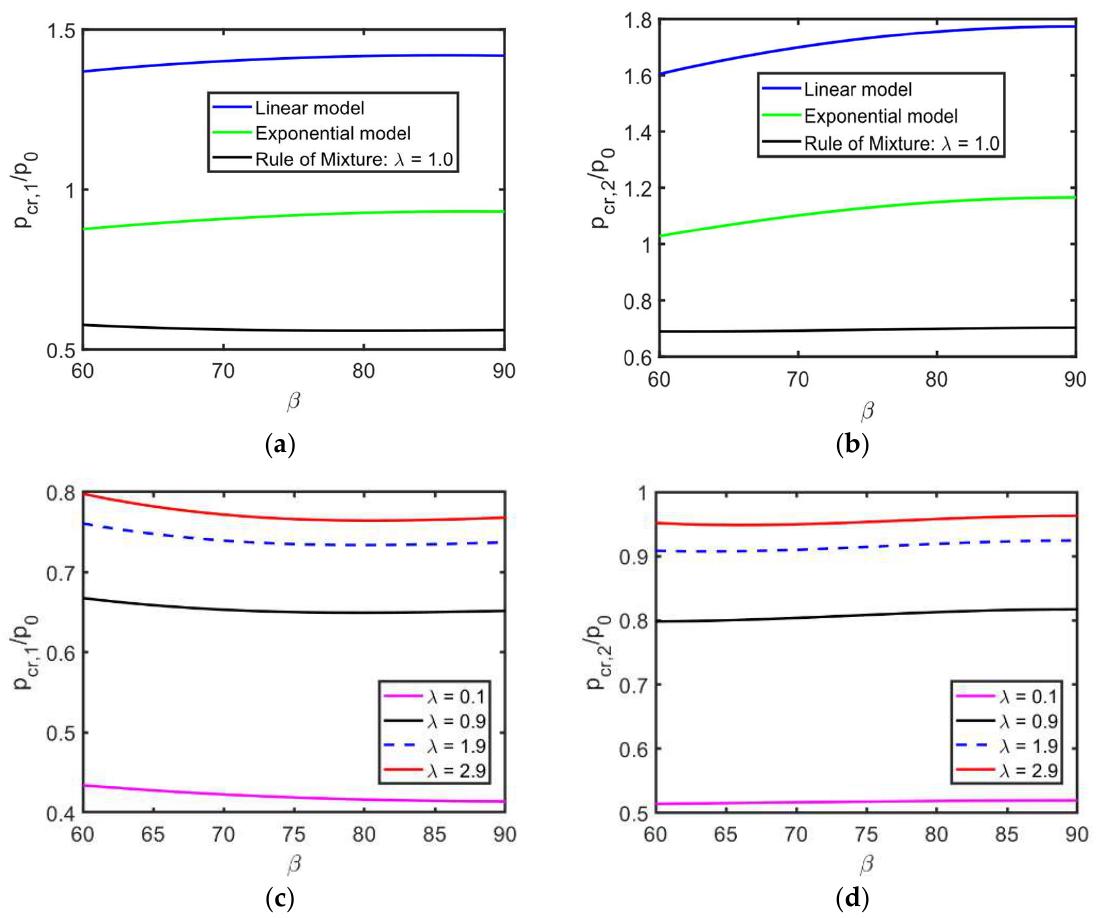
Figure 3. Critical loads as a function of β: ( a , b ) for three FG models; ( c , d ) for the rule of mixtures for different values of λ (0.1, 0.9, 1.9, and 2.9); ( a , c ) for crack 1 and ( b , d ) for middle crack 2.